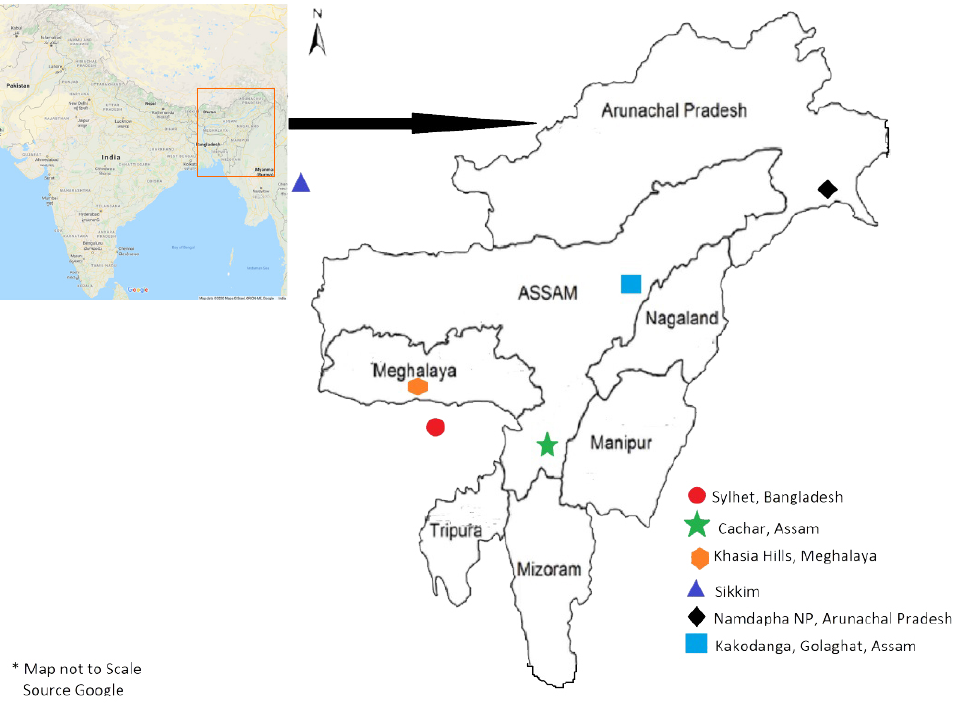
Figure 1. Known locations of Ceropegia lucida Wall. in northeastern